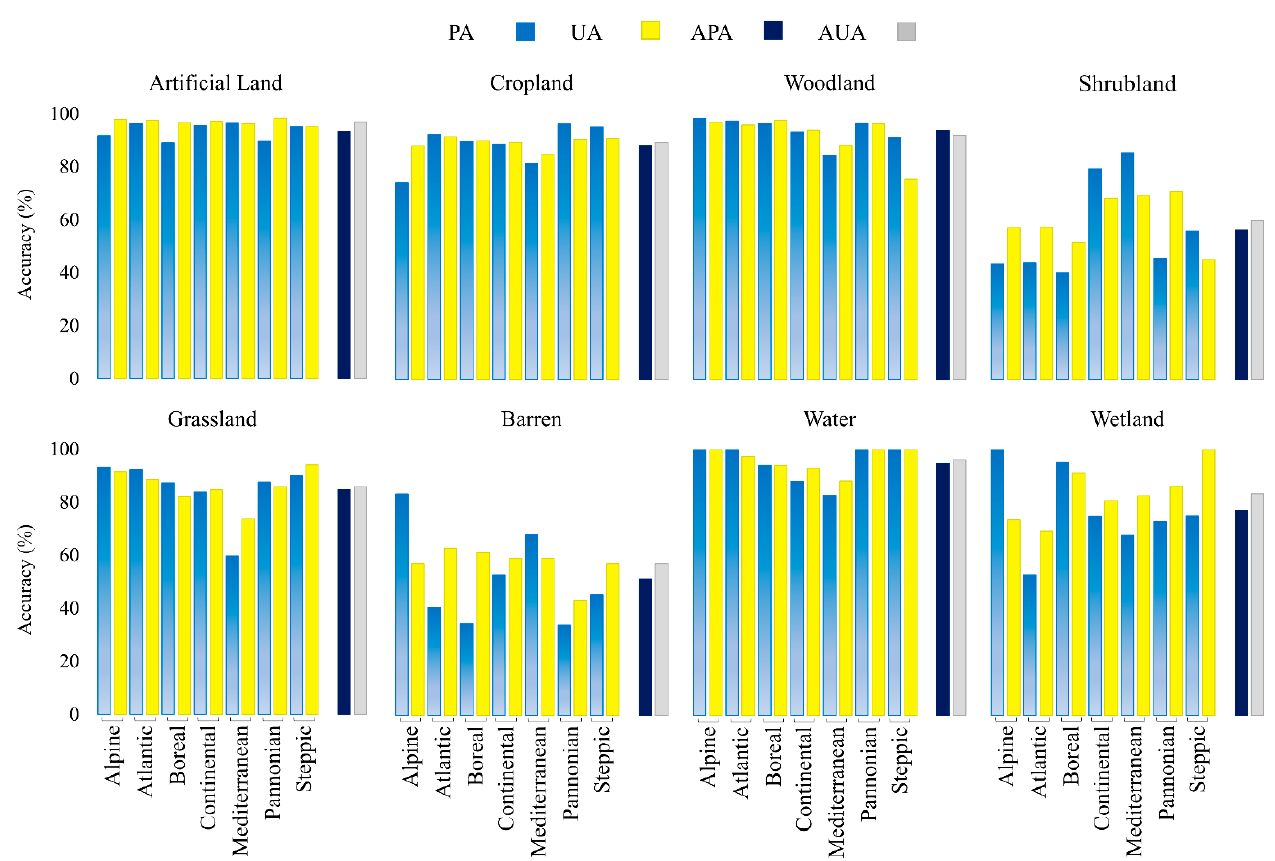
Figure 5. The accuracies report of all classes in all biogeographical regions, including OA, PA, UA, Average of Producer Accuracy (APA), and Average of User Accuracy (AUA) before post-pro-